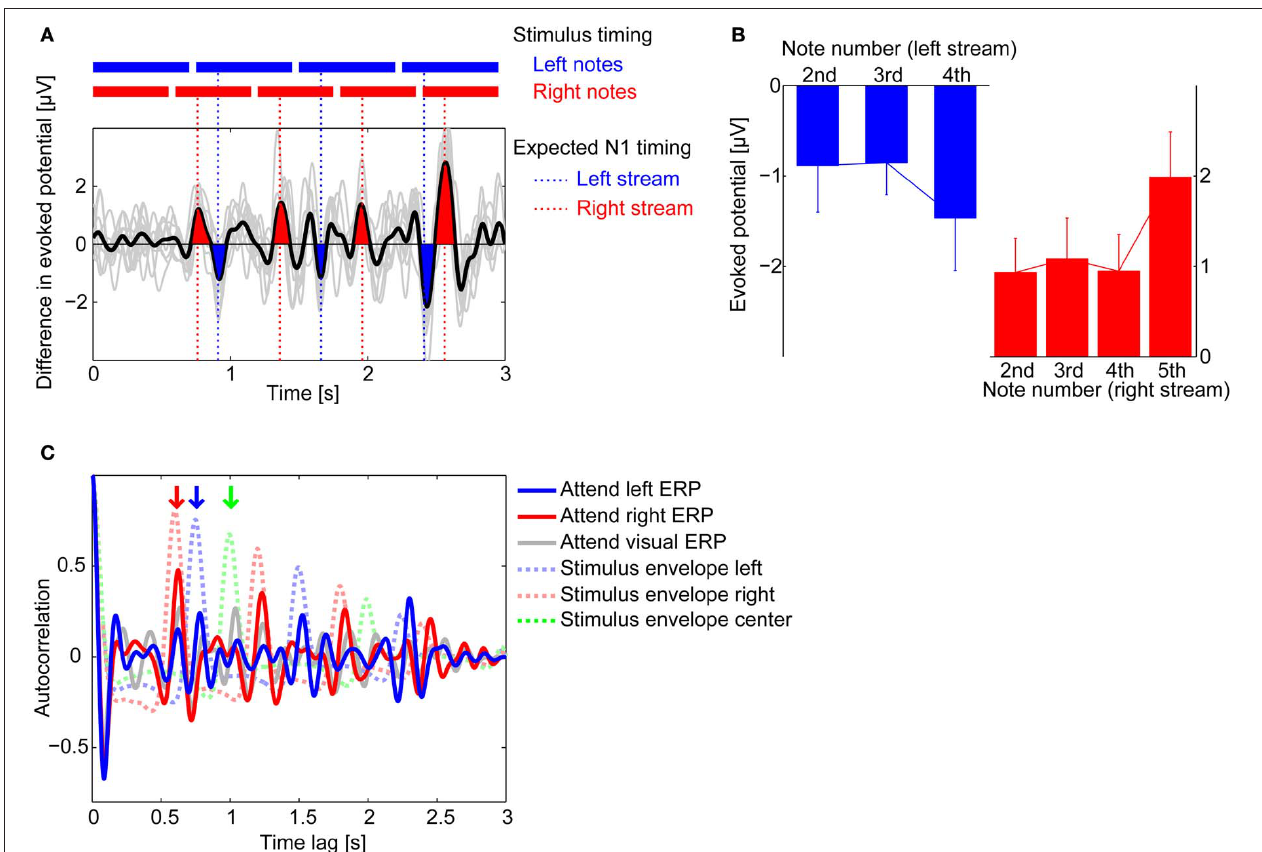
FIGURE 5 | Attentional modulation on averaged ERPs. (A) Difference in the grand average ERP waveforms at Fz between attend-left (blue) and attend-right (red) conditions (attend left–attend right). Thin gray lines show the differences computed for each individual subject average ERPs, while black line shows the across-subject average. Deflections around the expected times of the N1 response to notes in the right stream are colored in red; deflections around the expected times of the N1 response to notes in the left stream are colored in blue. Results are consistent with attention accentuating the N1 response to notes in the attended stream relative to when that stream is ignored. (B) Across-subject means ( ± standard deviation) of the